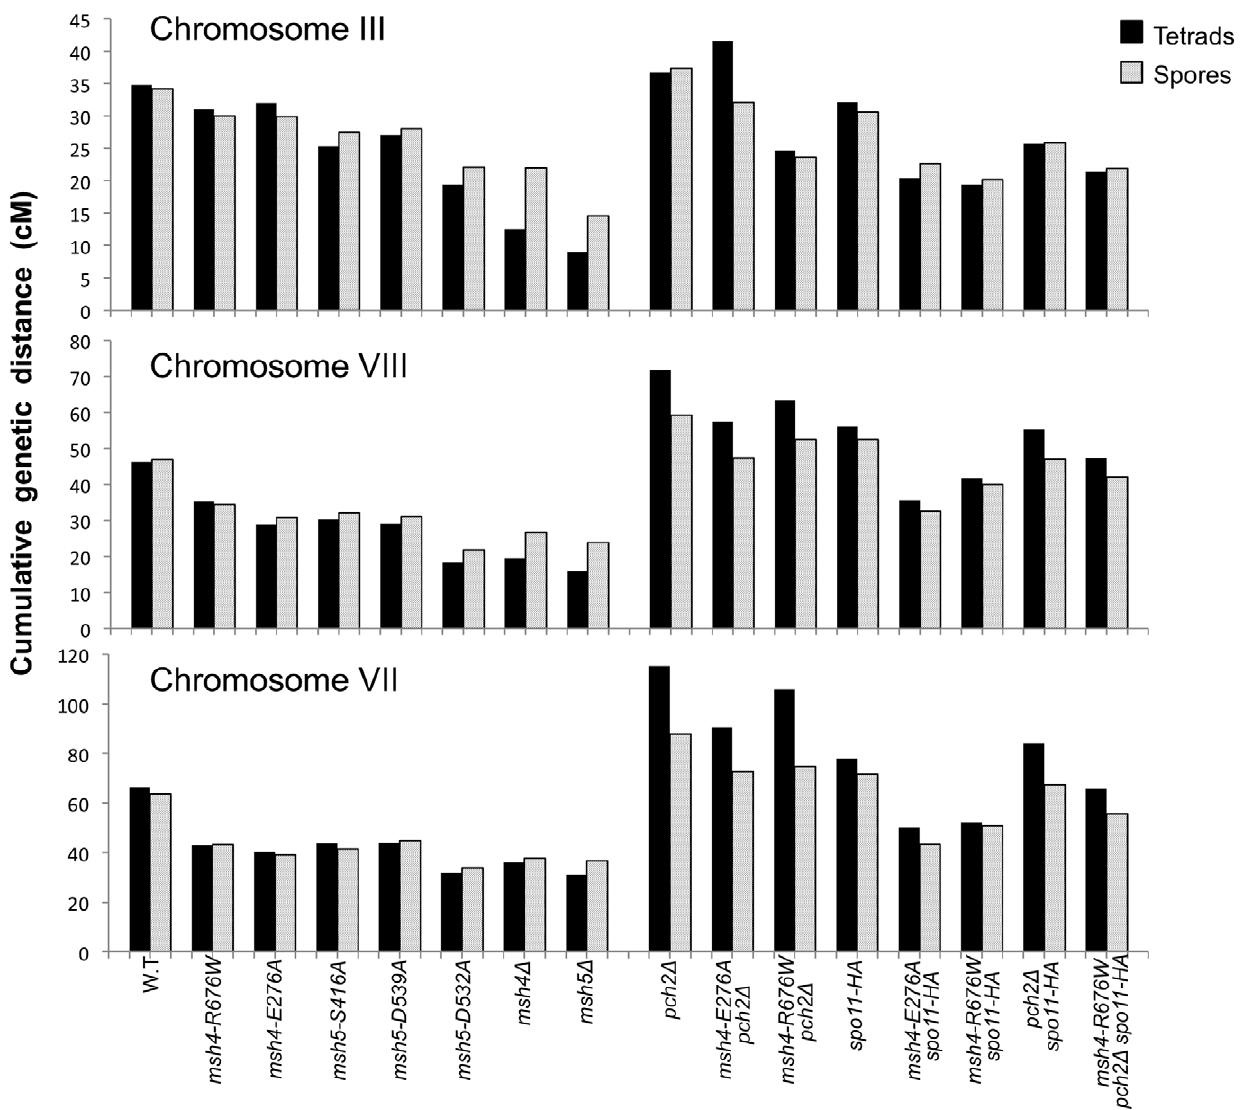
Figure 6. Chromosome size-dependent loss of the meiotic crossover buffer in msh4/5-t mutants. Cumulative genetic map distances for chromosomes III, VII, and VIII are shown separately for msh4/5 hypomorphs as well as their double and triple mutations with pch2 D and spo11-HA